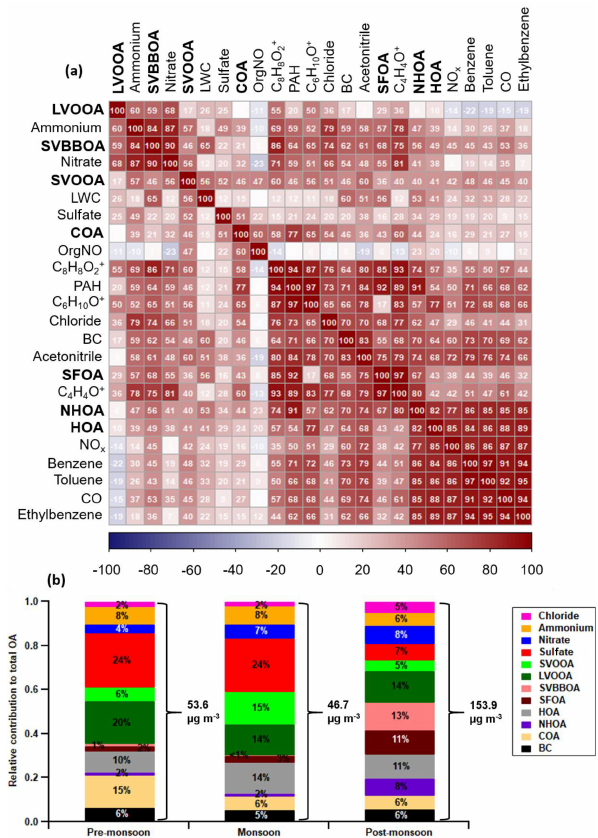
Figure 7. Correlation matrix (a) between the AMS OA factors (bold), internal tracers and external tracers for the combined dataset (all seasons). The correlation coefficients are ordered using hierar- chical cluster analysis. The relative contribution of OA factors, BC and inorganic species to total PM 1 for each period (b) where the total average PM 1 is shown using right curly brackets (see Table S5 for values and statistics). The three ions [C 6 H 10 O] + , [C 8 H 8 O 2 ] + and [C 4 H 4 O] + are, respectively, an organic acid fragment used for COA determination, a fragment of dibenzodioxin called benzodi- oxan, and a fragment of dibenzofuran called